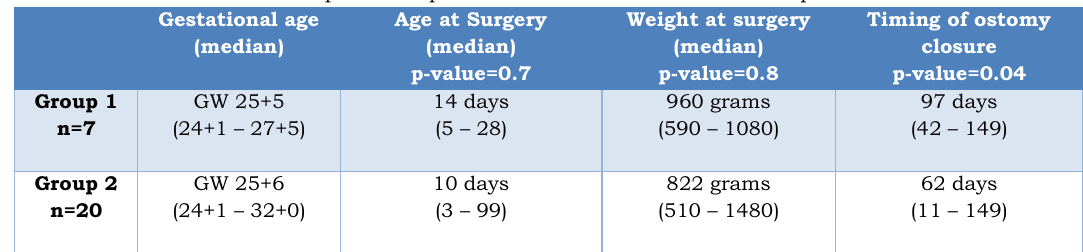
Table 2: Comparison of patients with and without stomal